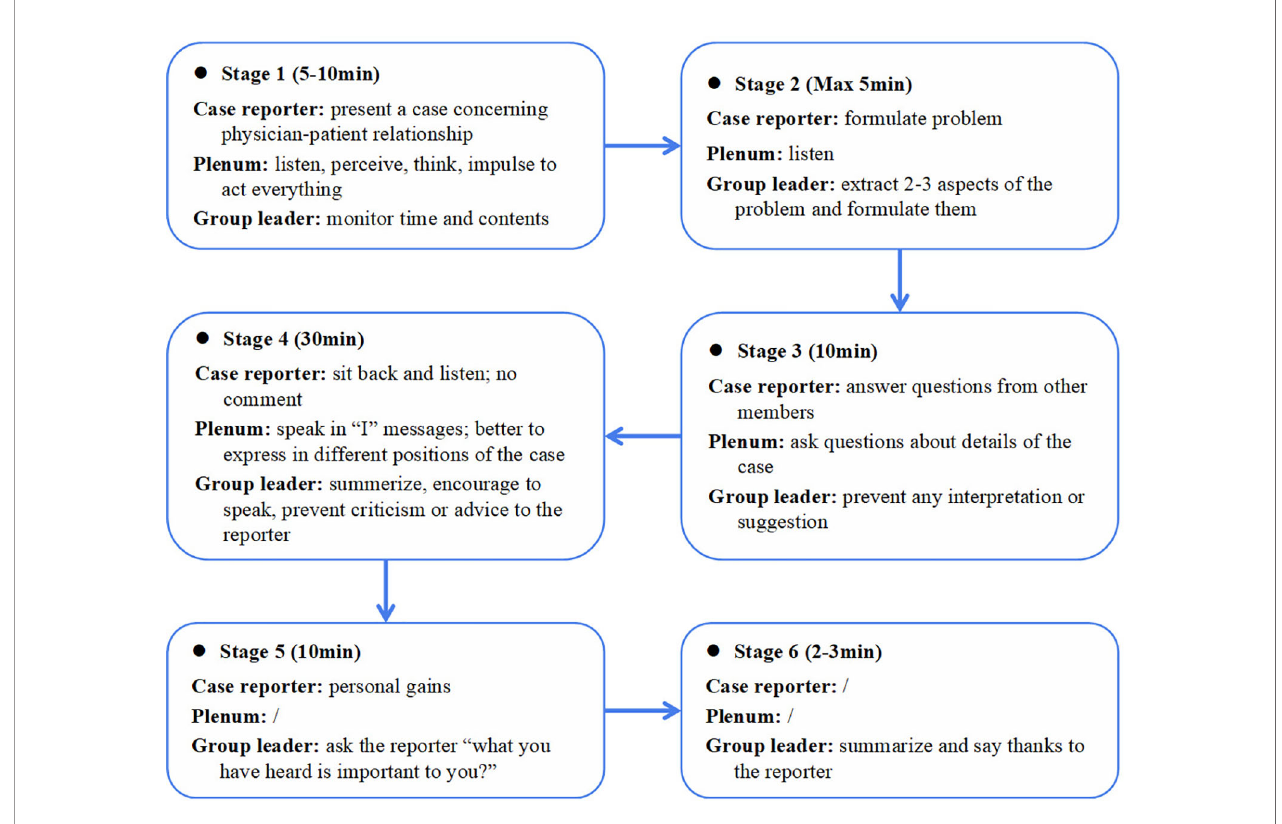
FIGURE 1 | Process of a typical Balint